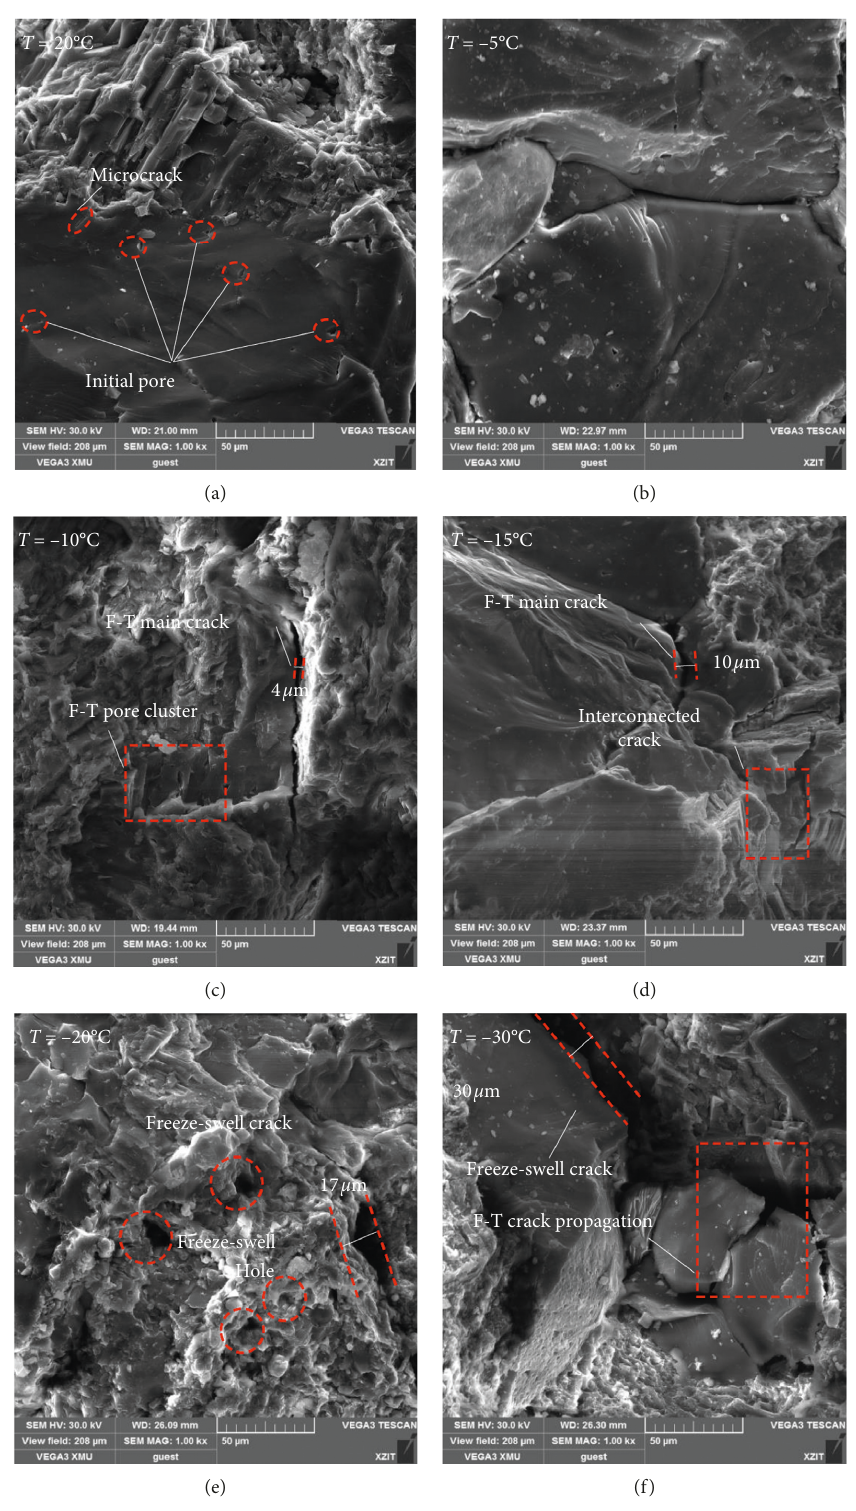
Figure 17: Microstructural characteristics of yellow sandstone under different F-T